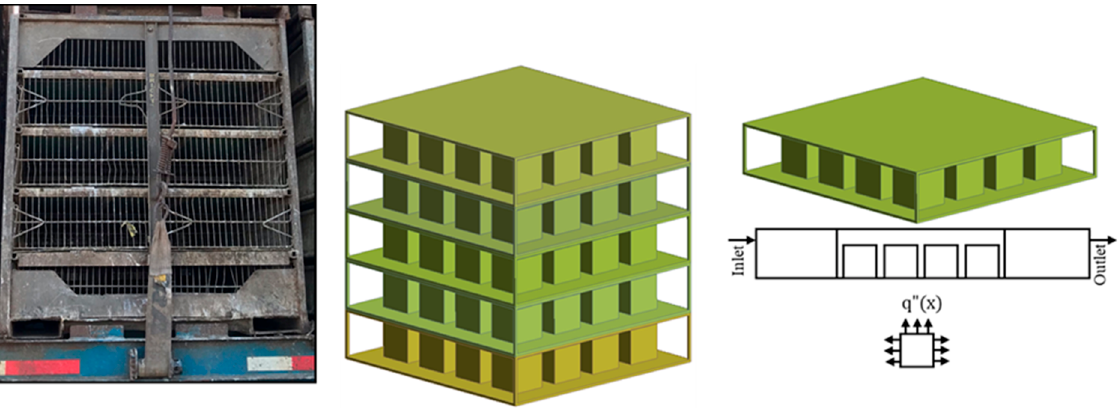
Figure 1. The stacks of poultry coops on a trailer, and the 3-D model for a single coop. Cubes represent broilers.